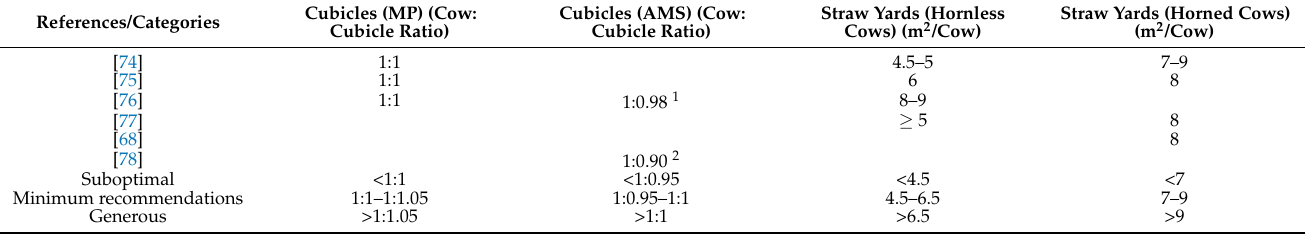
Table A2. Lying space–recommendations for herds with milking parlor (MP) or automatic milking system (AMS) and with horned or hornless cows, and categories for analyses derived from these recommendations.